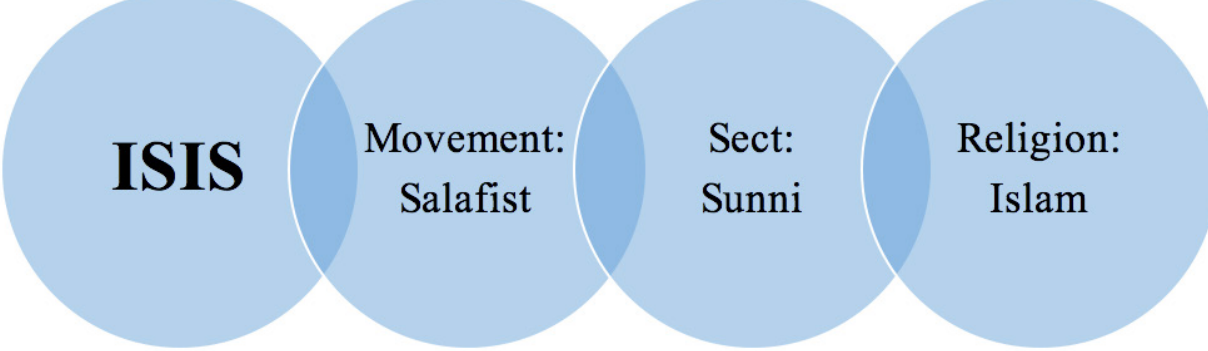
Figure 3: The relative location of ISIS on the continuum from cult to religion (Barron, 2016, p.